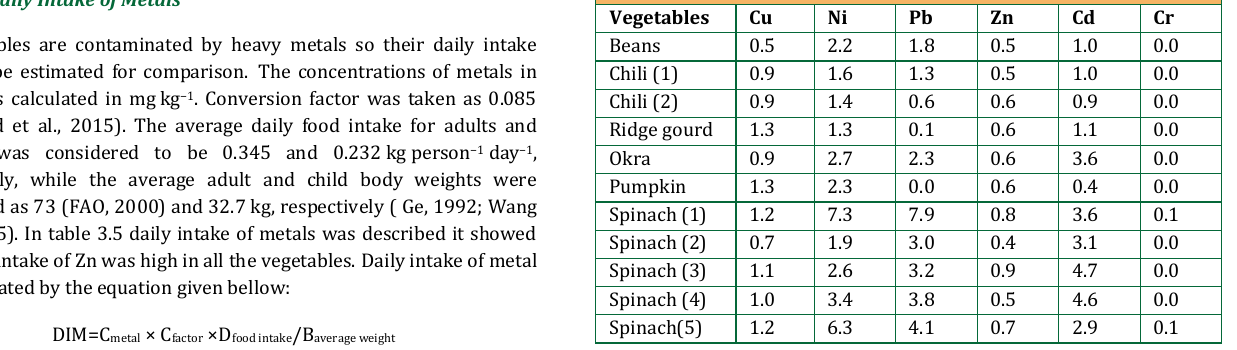
Table 10: Health Risk Assessment